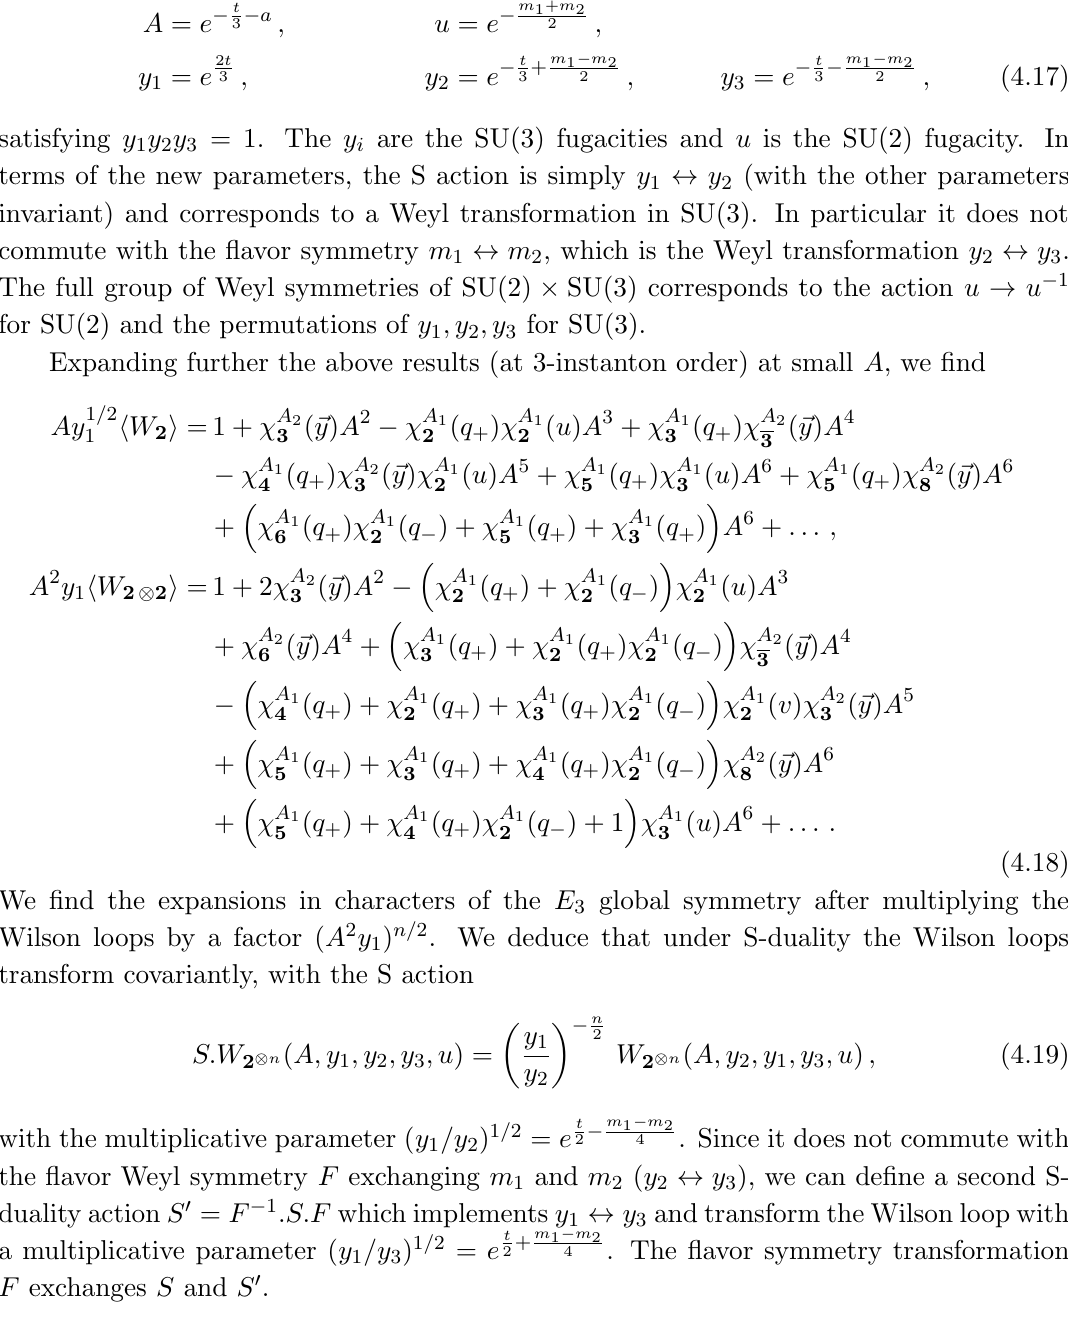
F exchanges S and S 0